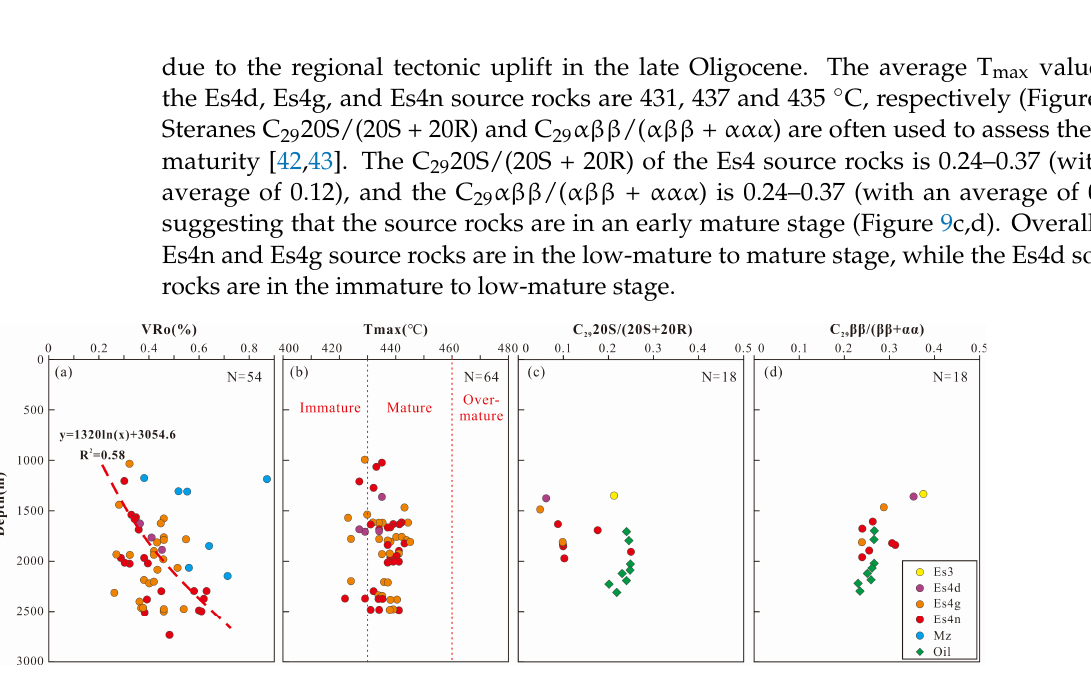
Figure 9. Thermal maturity of source rocks in the Niuxintuo area. ( a ) Ro. ( b ) T max . ( c ) C 29 20S/(20S + 20R). ( d ) C 29 αββ /( αββ + ααα ). (20S + 20R). ( d ) C 29 αββ /( αββ + ααα